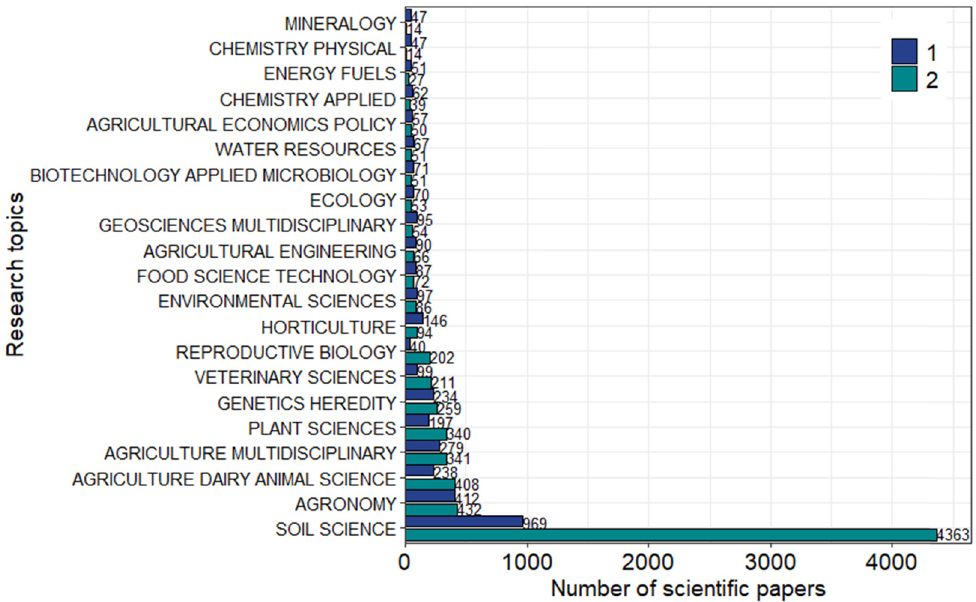
Figure 6: The number of scienti fi c papers distributed by WoS Categories, from 1992 to 2020. ( 1 ) By Russian authors co - authored with foreign authors. ( 2 ) By Russian authors only. Source: Own calculation using R software 4.0.2 ( 2021 ) based on the data aggregated by the Clarivate Analytics, WoS Core Collection ( 2021 )